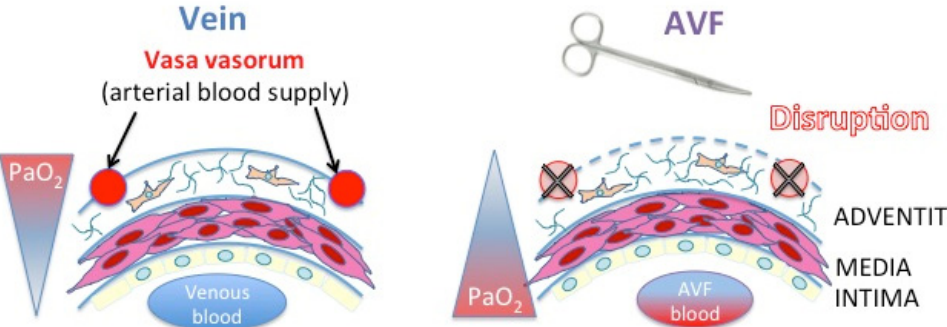
Figure 3. Changes in the venous wall after surgery: The vasa vasororum disruption creates a new oxygen gradient. The vasa vasorum in the adventitia provides oxygenated blood to the wall, whereas the intima is in contact with a venous blood low in oxygen. During surgery, the vein is dissected, disrupting the vasa vasorum , and potentially decreasing oxygen levels. On the other side, oxygenated arterial blood mixed to venous blood potentially creates an inversion of the oxygen gradient.